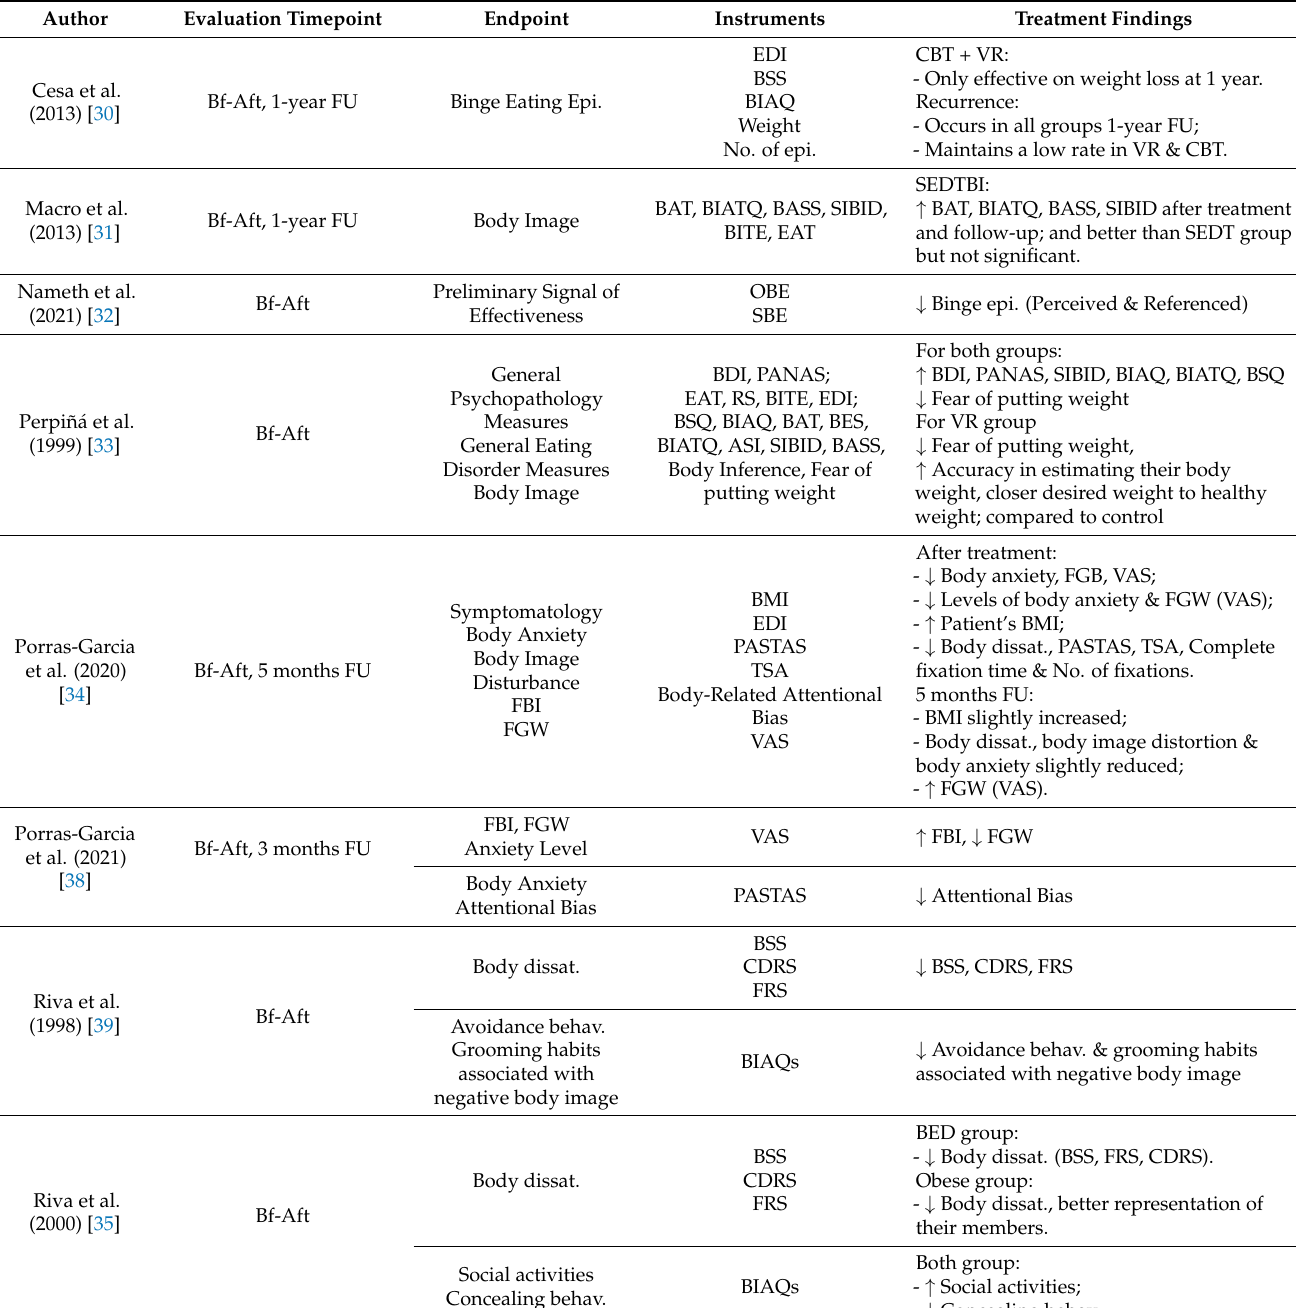
Table 6. Evaluation metrics and key findings of the reviewed